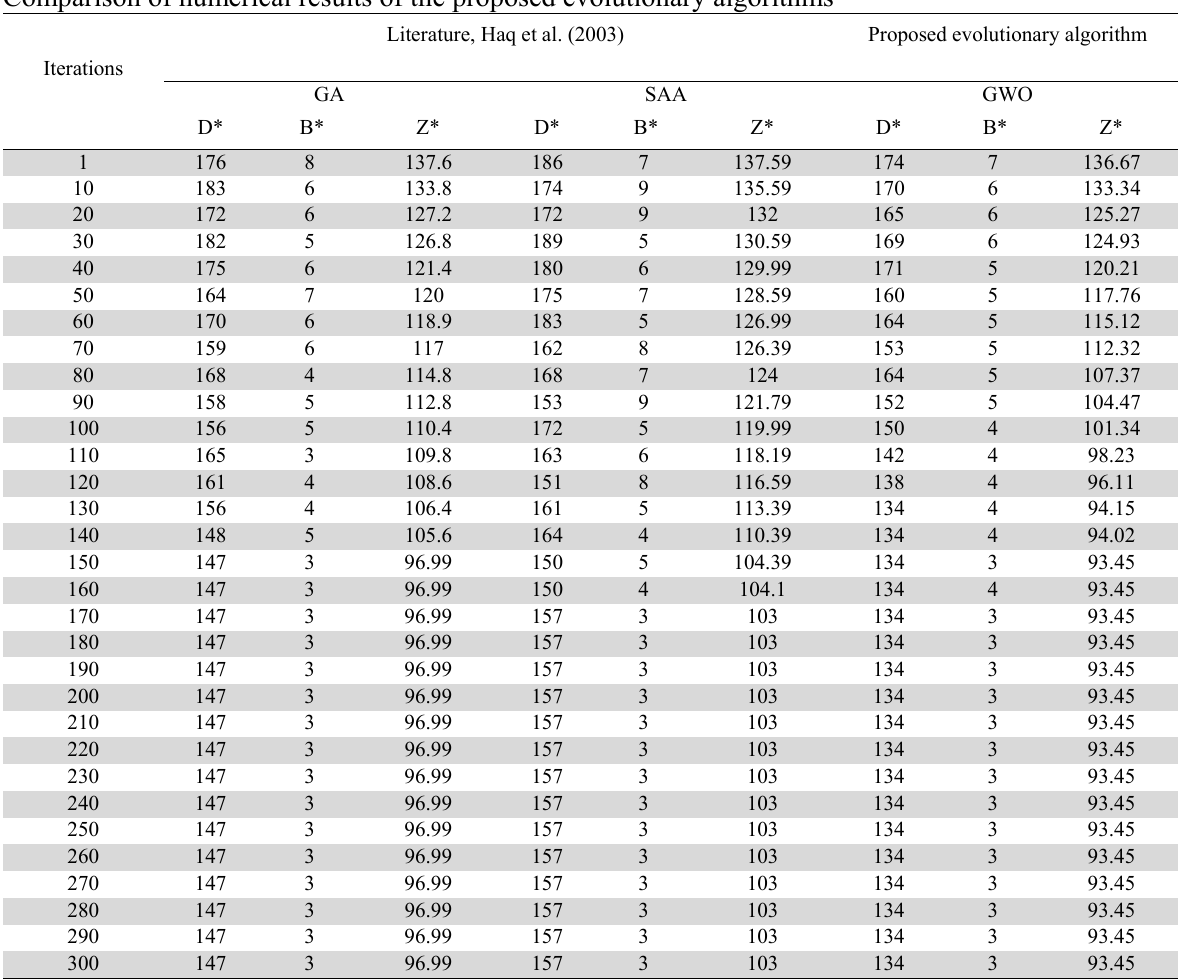
Comparison of numerical results of the proposed evolutionary algorithms